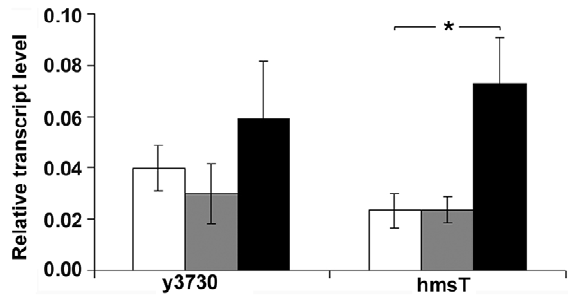
Figure 4. Expression of Y.pestis y3730 and hmsTinvitro and in the flea. Relative amounts of y3730 and hmsT mRNA expressed in fleas (black bars), in vitro biofilm cultures (grey bars) and in vitro planktonic cultures (white bars) are shown. The mean and SD of three independent experiments is indicated. * P , 0.05 by